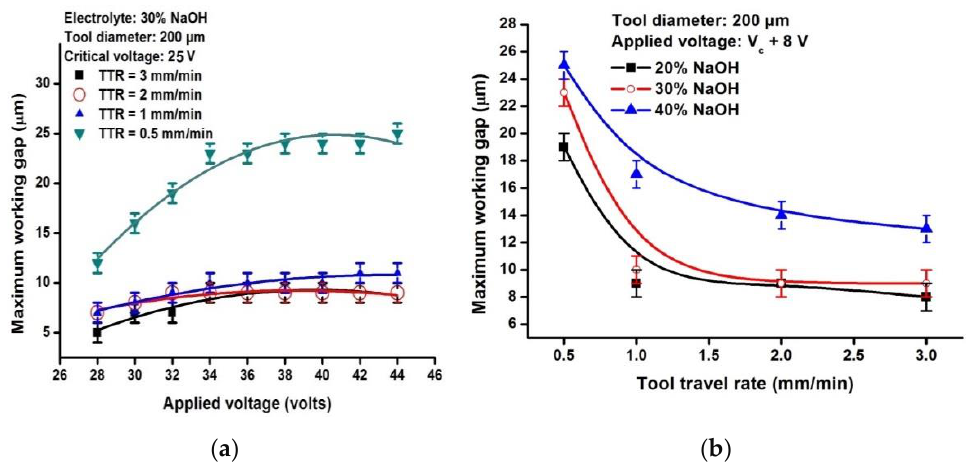
Figure 4. Variation of the maximum working gap beyond which no machining occurs for varying ( a ) applied voltages and tool travel rates and ( b ) tool travel rates and electrolytic concentration. The variation of maximum machining-assured Wg for various TTRs with an applied voltage of Vc + 8 V using three different electrolytic concentrations (20%, 30%, and 40% NaOH) is shown in Figure 4b. The critical voltage for an experimental condition with a 0.2 mm diameter tungsten carbide tool using 20% NaOH, 30% NaOH, and 40% NaOH are 26 V, 25 V, and 22 V, respectively. As the critical voltage is different for each electrolytic concentration, the experiments were performed at Vc + 8 V for comparison purposes. It can be observed that the maximum Wg decreases with increasing TTR values. This is due to the dispersion of the sparks that reduces its impact on material removal. The maximum Wg is higher for 40% NaOH when compared with 20% NaOH which may be attributed to the high intensity of the sparks at the higher electrolytic concentration for the fixed value of machining voltage. The difference in maximum Wg for all three electrolytic concentrations is observed to be less pronounced with an increase in TTR.